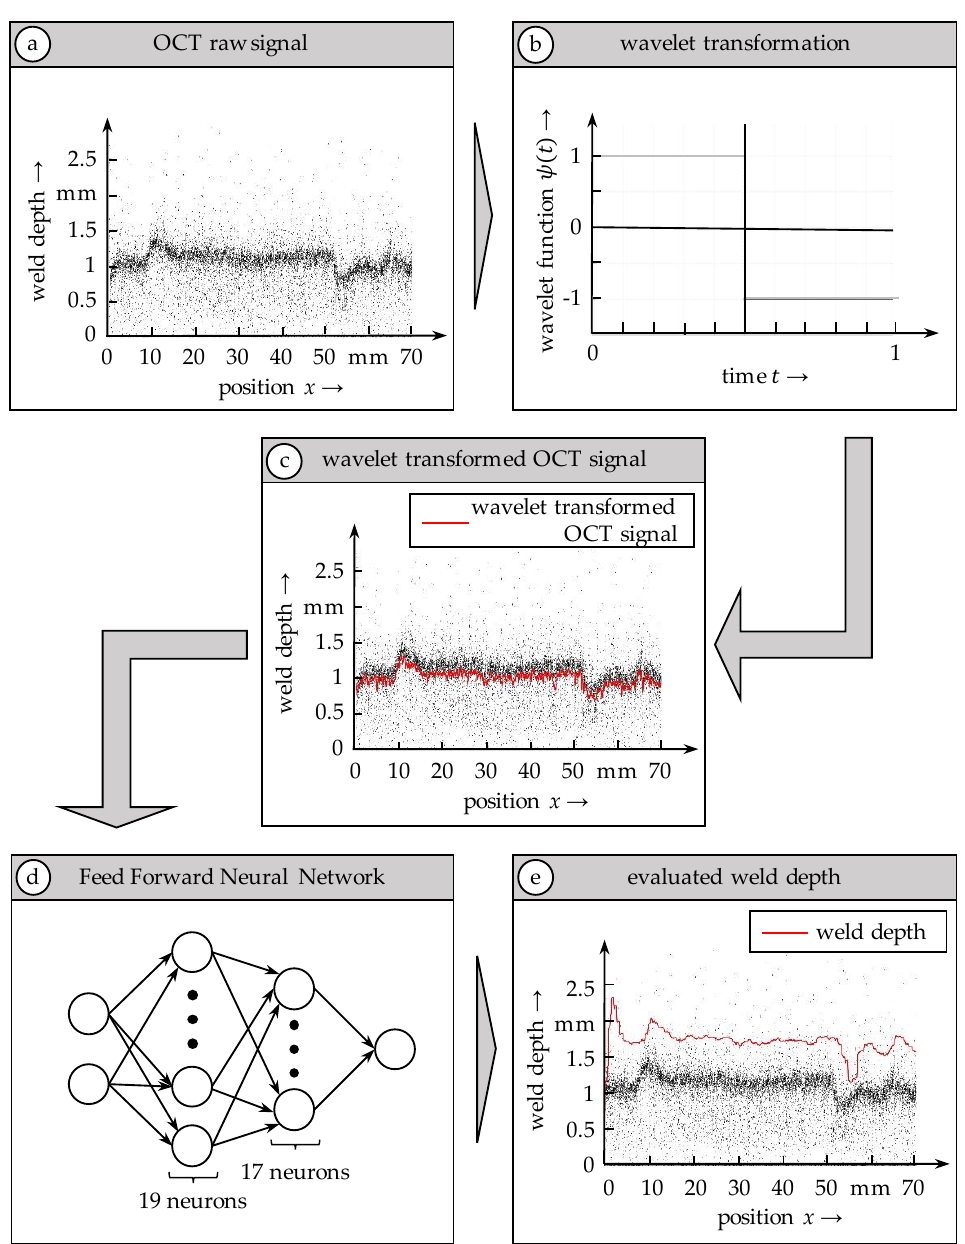
Figure 4. Sequence of the interpretation of the OCT keyhole depth measurement signal with respect to the weld depth, taking into account the identified signal influencing parameters using a wavelet transformation and an FFNN.